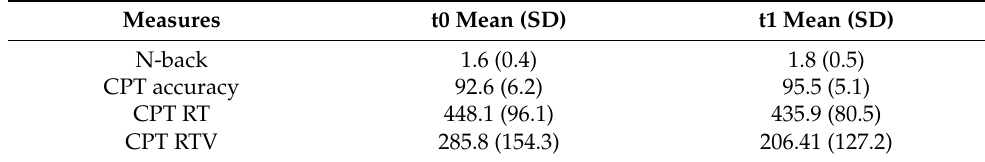
Table 2. Comparisons between t0-t1 on neuropsychological